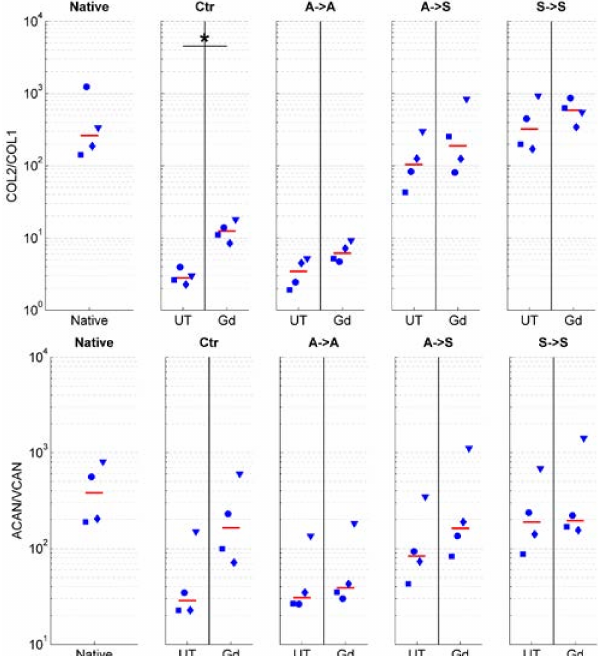
Figure 6. Influence of 20 mM gadolinium on chondrocyte dedifferentiation marker. The degree of dedifferentiation was quantified by the mRNA expression ratios of collagen type II to type I ( COL2 / COL1 ; top ) and aggrecan to versican ( ACAN / VCAN ; bottom ). High values of these ratios indicate differentiated chondrocytes, whereas low values indicate dedifferentiated cells. The application of gadolinium resulted in a higher COL2 / COL1 and ACAN / VCAN expression compared with the untreated cells. The blue markers indicate the individual values of the four unique animals (unique shape for each animal), and the red line indicates the median from all of the experiments. The asterisks indicate a statistically significant difference between the gadolinium-treated and corresponding untreated group. The nomenclature of the samples is indicated in Figure